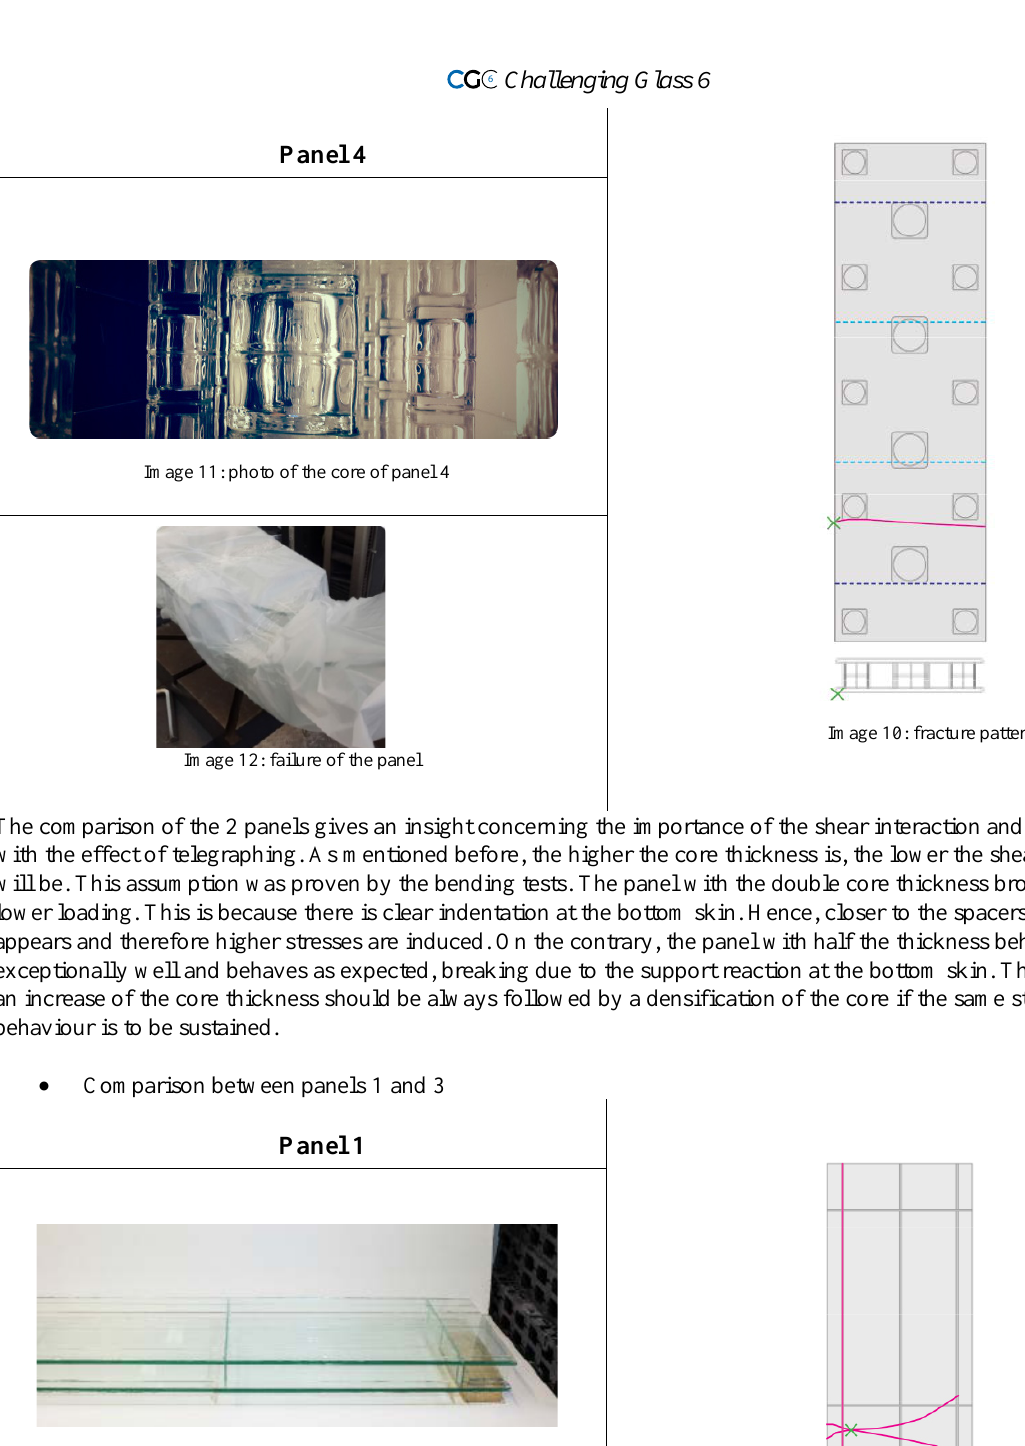
Image 14: photo of the panel